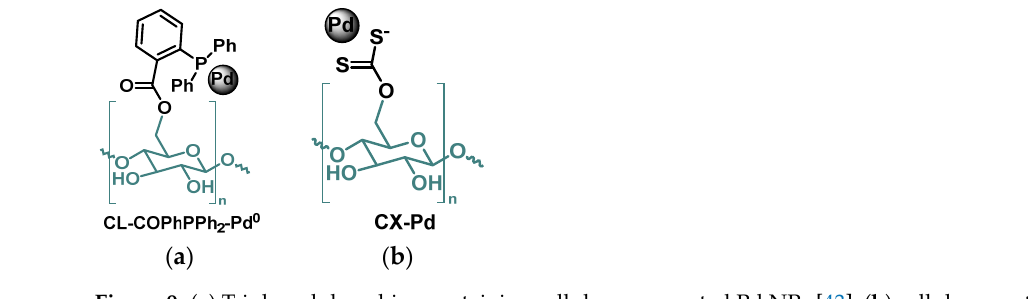
Figure 11. Reduction of Pd(II) onto cellulose as Pd NPs [84]. Cellulose Composites Pd NPs supported by an ammonium-derivatized hyperbranched polystyrene have been glued to filter paper and cotton wool to form dip catalysts [70]. Both were utilized to catalyze the quantitative coupling reaction of phenyl iodide with t -butyl acrylate or sty- rene, at 80 °C in water with K 2 CO 3 for 24 h. The adhesion of the polystyrene-supported NPs to the cellulose was found very strong so that the dip catalyst could be used five times in a row with almost no Pd leaching detected and a yield still over 99%. Interestingly, the same “black filter paper” could be successively recycled to catalyze the couplings of dif- ferent substrates for each run. Masteri–Farahani and his team have devised another magnetic nanocomposite, this one made of graphene oxide (GO) and cellulose [85]. Iron ions were precipitated as Fe 3 O 4 NPs in the sites offered by GO. Cellulose was grafted to GO via click-chemistry after ade- quate derivatization. The abundant OH groups of cellulose highly stabilized Pd NPs uni- formly dispersed over it. The resulting nanocomposite served as a heterogeneous catalyst for C-C coupling of iodobenzene with n -butyl acrylate in various deep eutectic solvents (DES). In optimized conditions (at 100 °C in dimethylammonium chloride:glycerol, with K 2 CO 3 ), 98% yield was reached after 5 h. The Heck reaction was also conducted with dif-